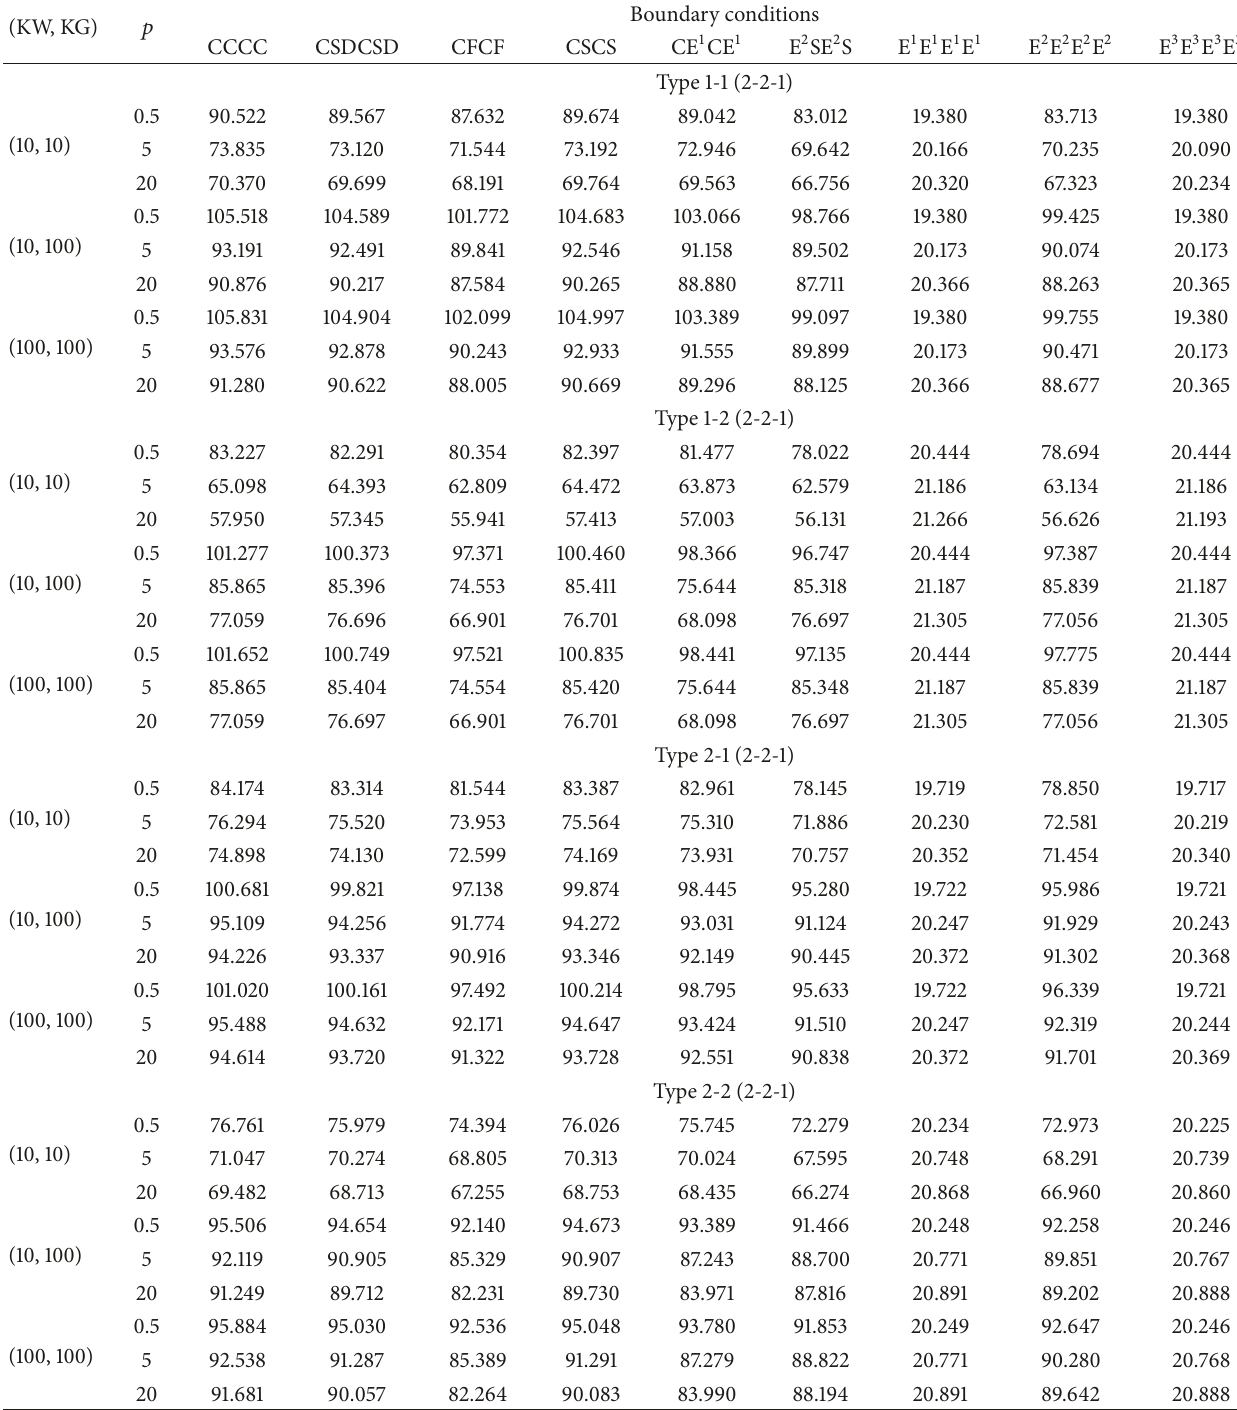
Table 14: Fundamental frequency parameter Ω for annular sector plate with various boundary conditions and material types ( 𝑅 0 /𝑅 1 = 0.5, 𝜙 = 120 ∘ , ℎ/𝑅 𝑝 1 = 𝑝 2 = 𝑝 3 = 𝑝 1 = 0.2, and